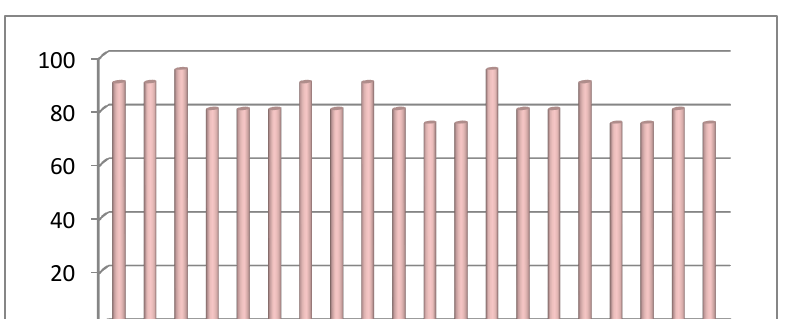
Figure 3. Diagram Result of the Test in Cycle